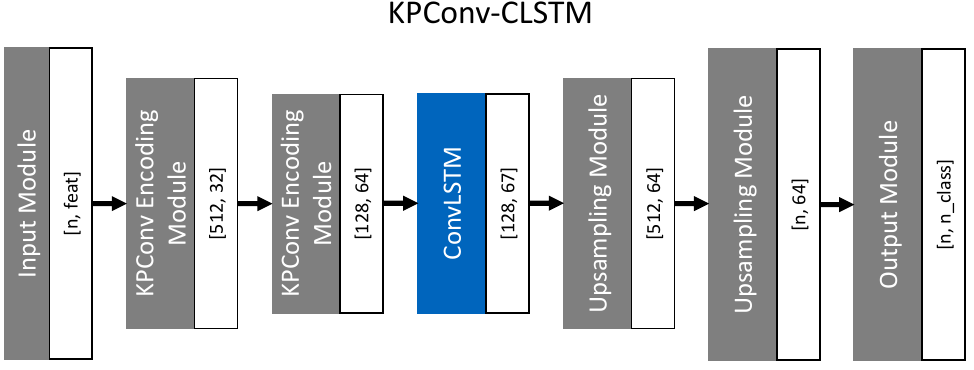
Figure 3. High-level structure of our KPConv model with ConvLSTM cells in the latent space. The blue color shows layers that consider time